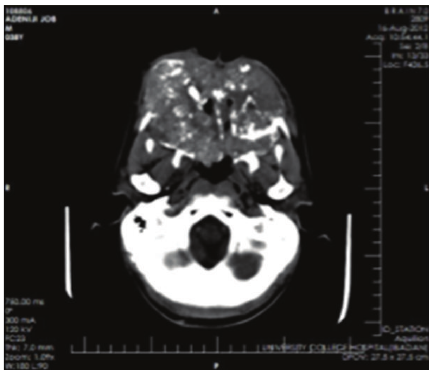
Figure4:CoronalCTshowinginvolvementoftheparanasalsinuses and orbital floor.